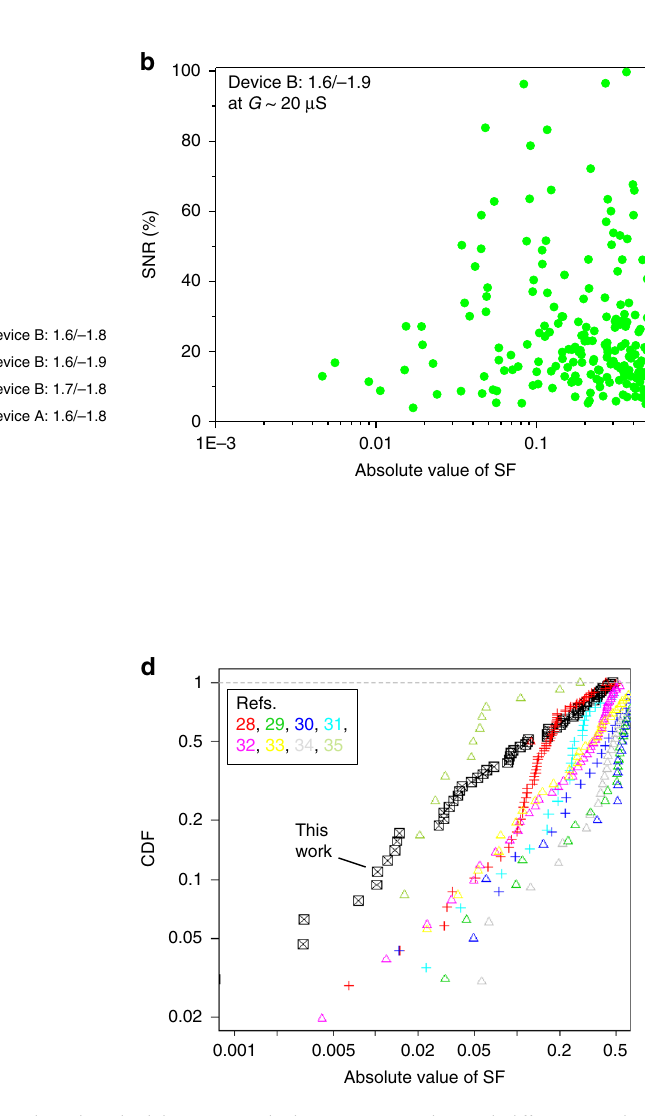
Fig. 4 Tradeoff between switching symmetry and SNR for ReRAM. The GPR-based methodology was applied to our ReRAM data with different metal oxide thicknesses (device A: 5 nm, device B: 4 nm) and different set (1.6 – 1.7 V) and reset ( − 1.8 to − 1.9 V) voltages to investigate the relationships between the key metrics. a SNR and SF as functions of G . The original data for two representative device and pulse conditions are shown in the insets to contrast the tradeoff. b Cross-sectional 2D plot of SNR versus SF taken at G ~20 μ s from a . c Plot of cumulative distribution function (CDF) of absolute values of SF for data in different SNR ranges. d Benchmark plot of SF. The optimized ReRAM data (device A, set: 1.6 V, reset: − 1.8 V) were compared with refs. 28 – 35 . The benchmark data points are color-coded (see the legend) and shown as symbols for same amplitude pulses and as crosses for varying amplitude